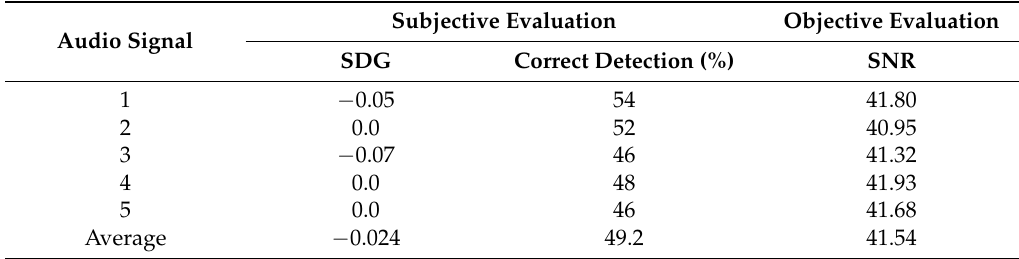
Table 2. Subjective and objective evaluation of different watermarked sounds.